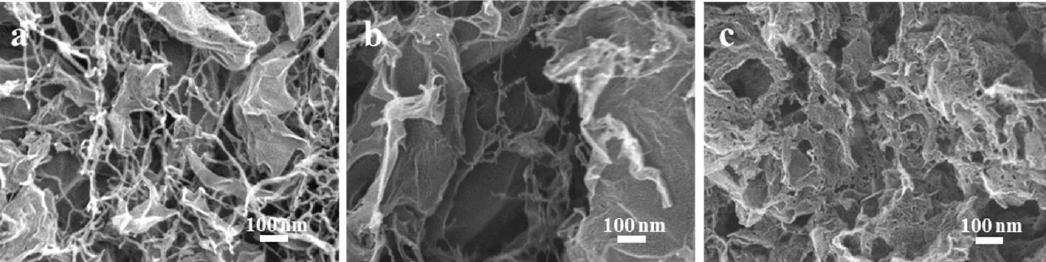
Figure 13. SEM images of carbon nanofiber/graphene oxide aerogels with different compositions treated at two different temperatures: ( a ) nanofiber: GO = 9:1, heat treated at 750 °C, ( b ) nanofiber: treated at two di ff erent temperatures: ( a ) nanofiber: GO = 9:1, heat treated at 750 ◦ C, ( b ) nanofiber: GO = 8:2, heat treated at 750 °C, ( c ) nanofiber: GO = 9:1, heat treated at 1100 °C. Reprinted with GO = 8:2, heat treated at 750 ◦ C, ( c ) nanofiber: GO = 9:1, heat treated at 1100 ◦ C. Reprinted with permission from [49]. Copyright © 2019 American Chemical Society. permission from [49]. Copyright © 2019 American Chemical